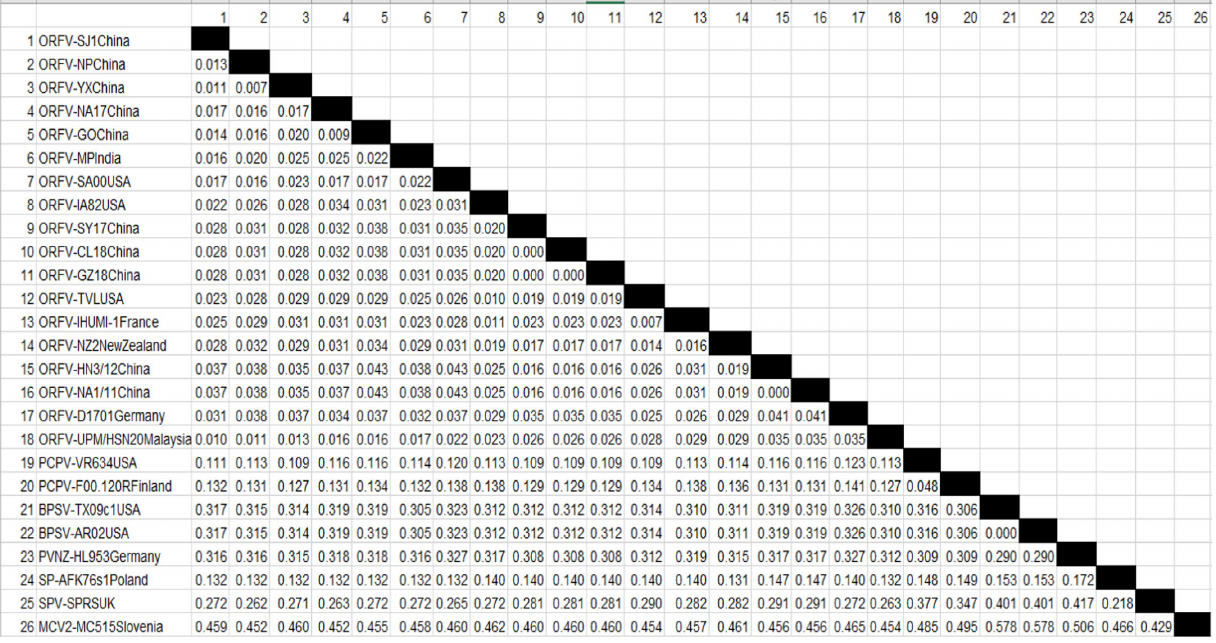
TABLE 2 | Estimates of Evolutionary Divergence between Orf virus UPM/HSN-20 and other reference